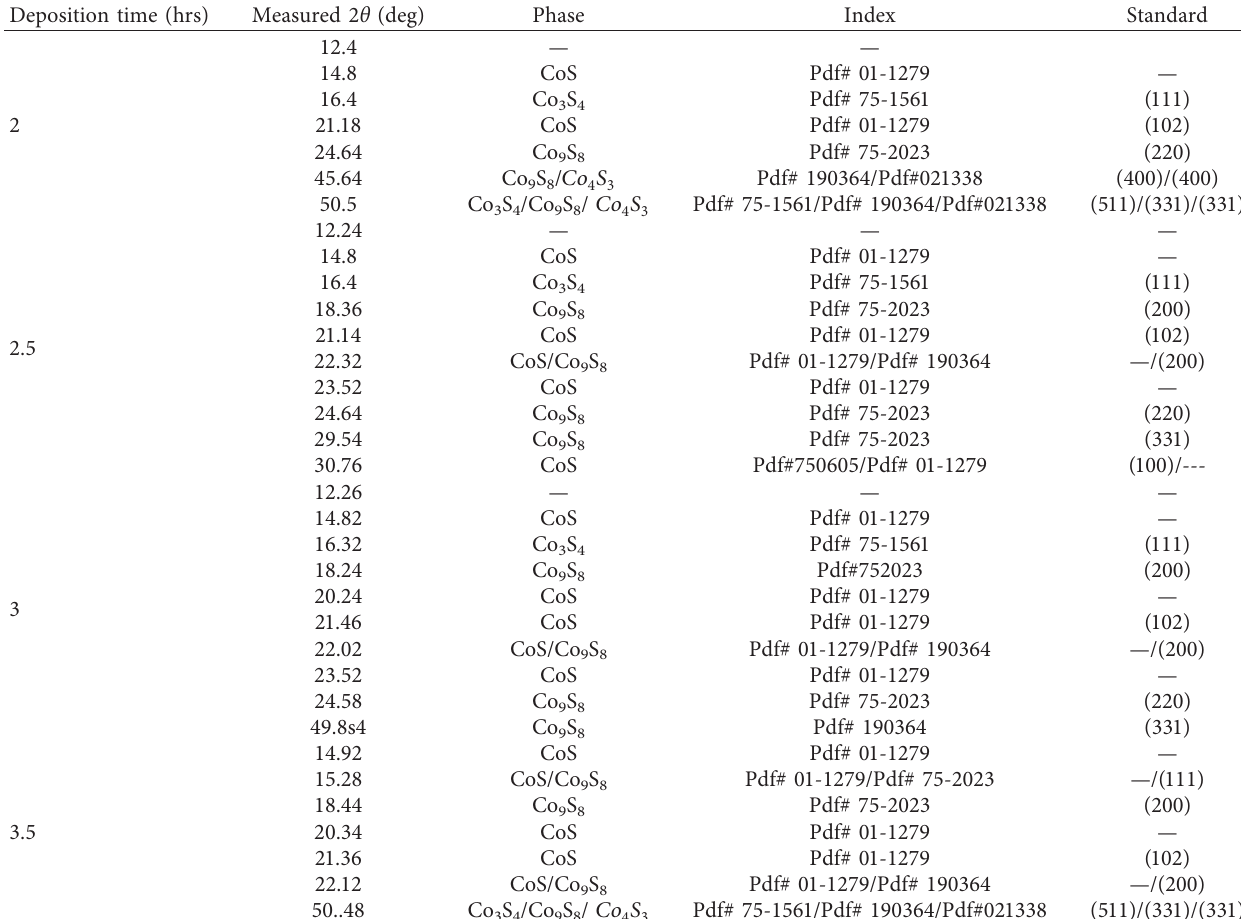
Table 1: Some structural parameters of cobalt sulfide thin films and their reference Pdf file numbers. Deposition time (hrs)